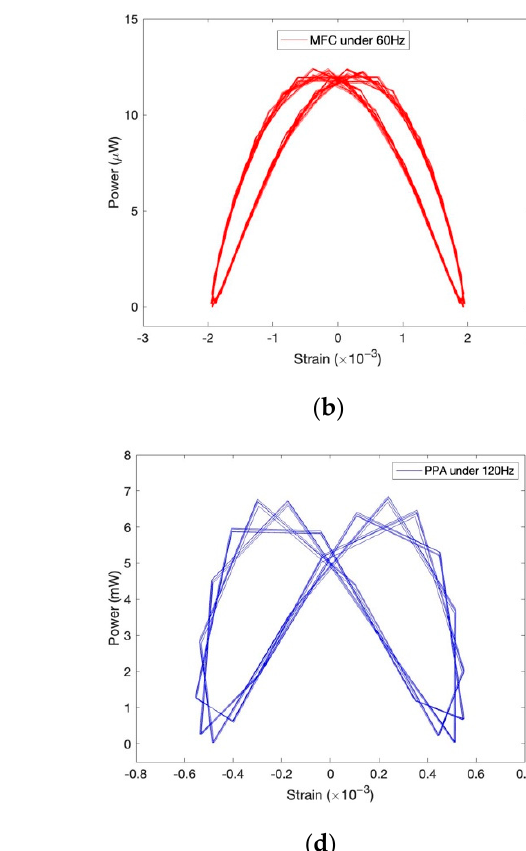
( b ) Figure 8. Normalized-harvested powers by varying load resistances for MFC and PPA. ( a ) Power vs. resistance for MFC; ( b ) Power vs. resistance for PPA. 2.3.5. Appropriate Excitation Amplitude Determination We also observe how the excitation amplitude load affects the generated power. Fig- ure 9 displays the relationship of the generated peak/average power with the excitation amplitude from the PPA harvester under two typical cases. In Figure 9a for the case of 100 Hz frequency, 10 kOhm resistance without mass, the results demonstrate that a larger excitation amplitude stimulates more electric power. In addition, the power increases